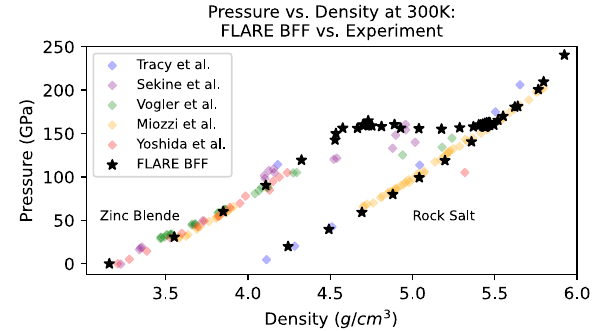
Fig. 4 The density-pressure relation from experimental measure- ments 25 – 29 and MD simulations from FLARE BFF. Zinc blende and rock salt phases correspond to two different curves of equation of state. Our FLARE BFF shows close agreement with